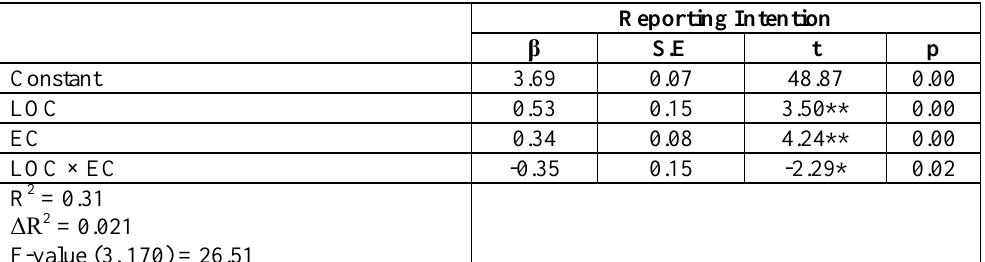
Table 2. Results of the Moderating Effect of Ethical Culture on the Relationship between Locus of Control and Reporting